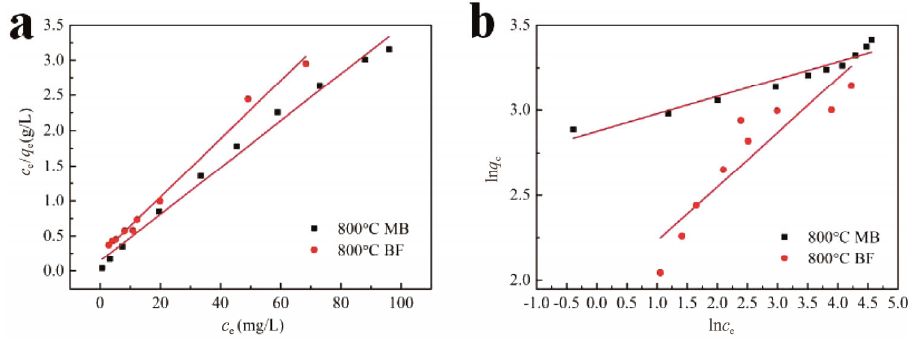
Fig. 12 Linear fits of the isotherm models for MB and BF adsorption: (a) Langmuir, (b) Freundich.